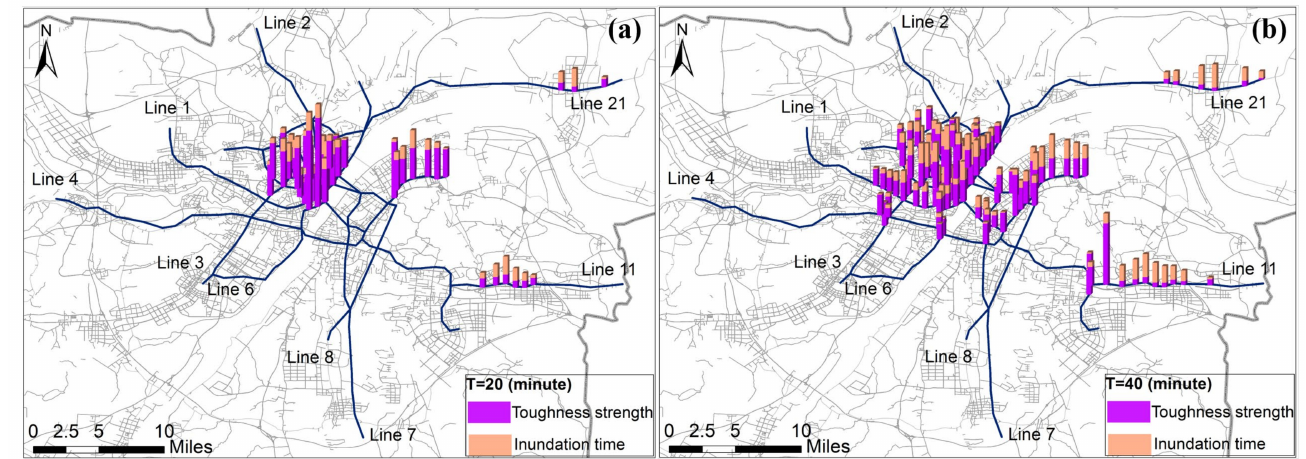
Figure 16. Diagram of inundation time and toughness strength of nodes at T = 20 min ( a ) and T = 40 min ( b ).